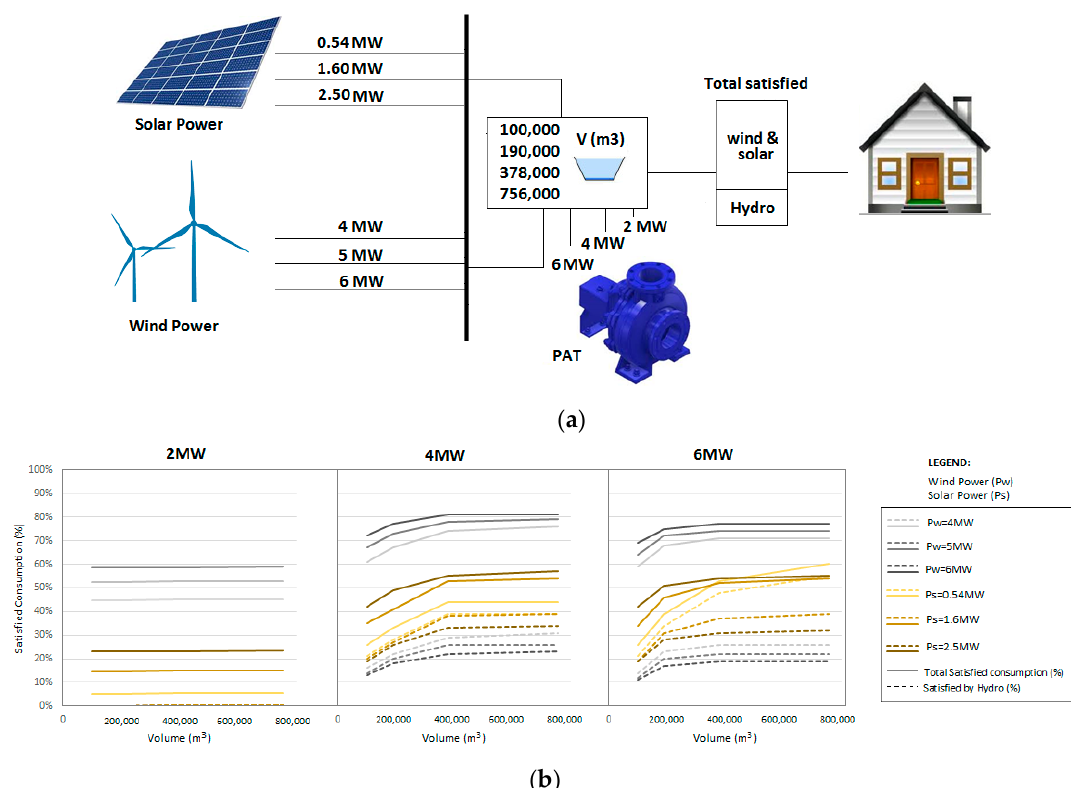
Figure 5. Hybrid solution: shematic diagram of di ff erent combinations used ( a ); satisfied demand (wind + hydro; solar + hydro; hydro) for di ff erent pump as turbine (PAT)’s power ( b ).